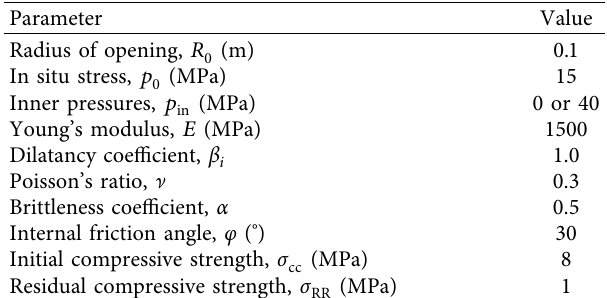
Table 2: Geometrical and physical parameters of circular opening (data from Li et al. [23]).